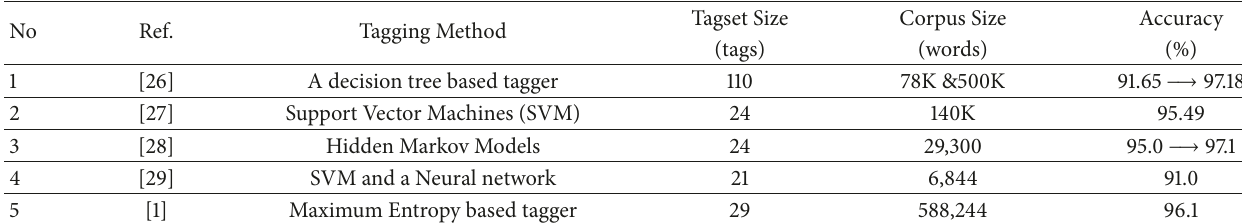
Table 2: Some of the literature tagging